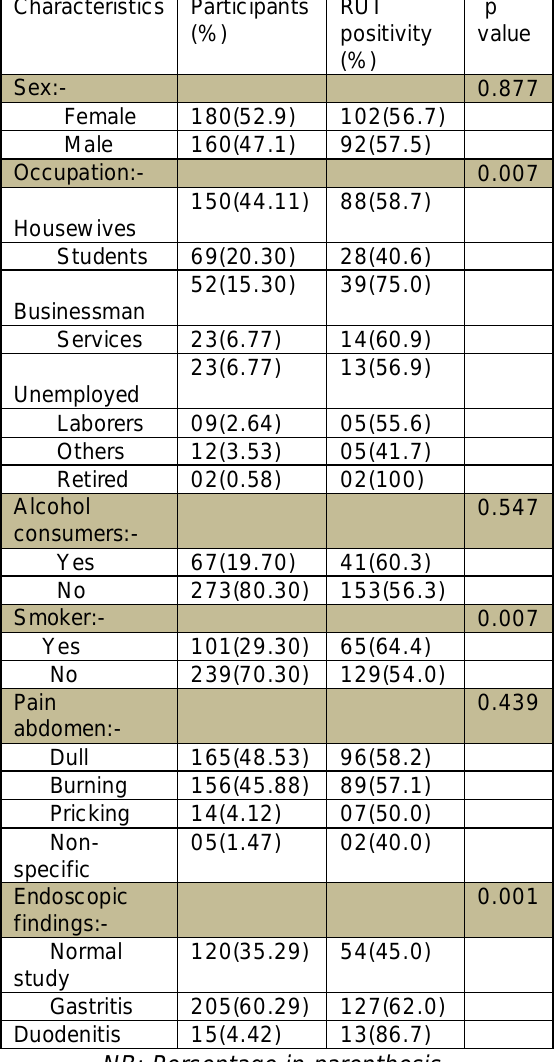
Table 2. RUT positivity, Demographic,